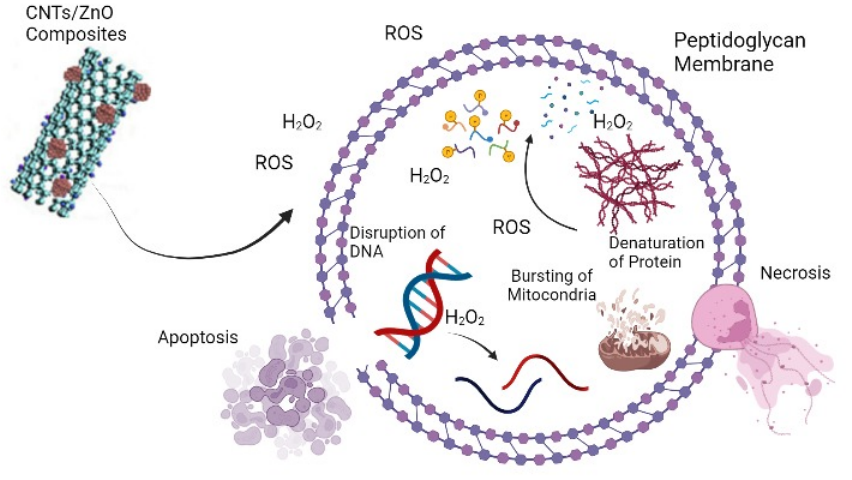
Figure 1. Proposed mechanism of CNTs/ZnO composite antibacterial activity.